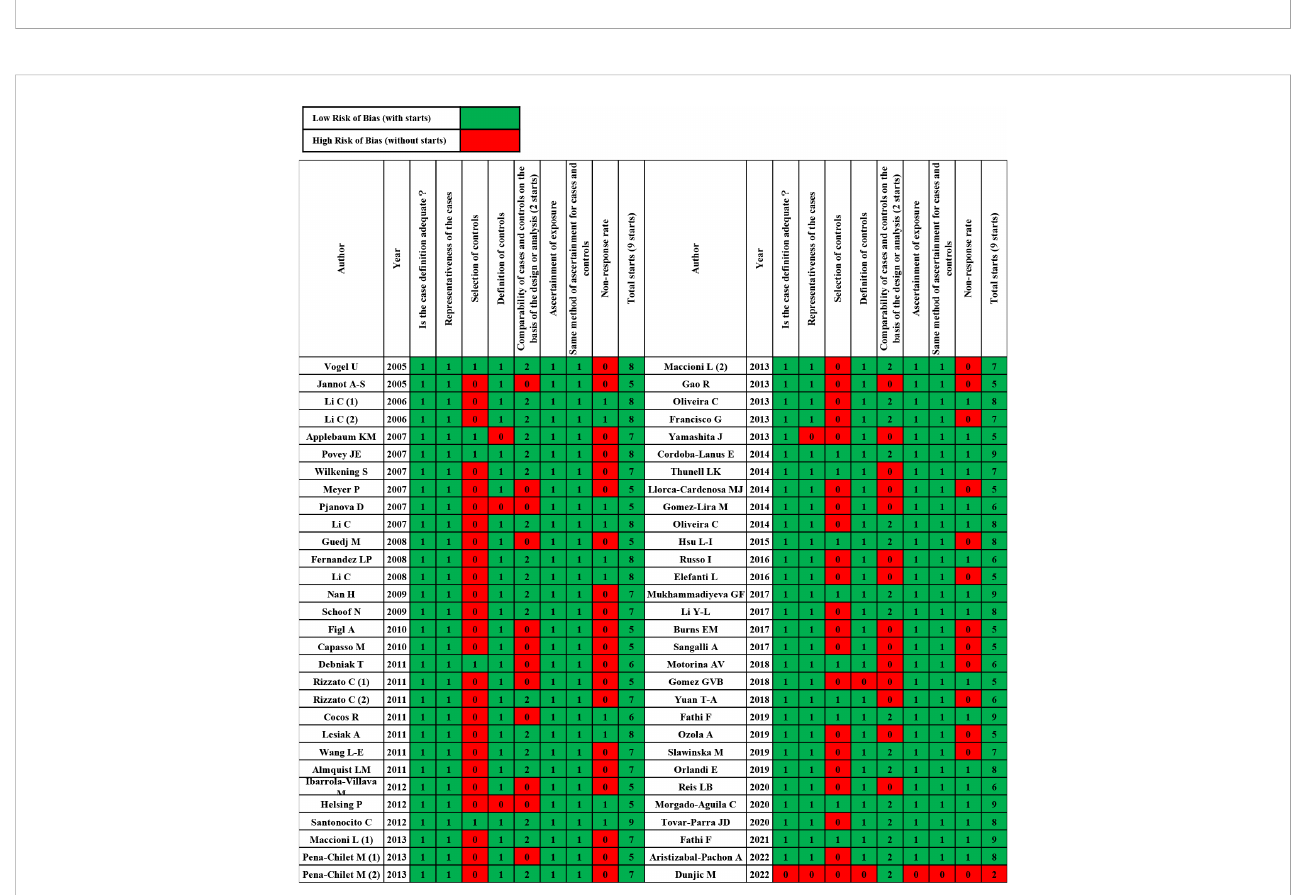
FIGURE 1 PRISMA fl ow diagram for network meta-analysis.